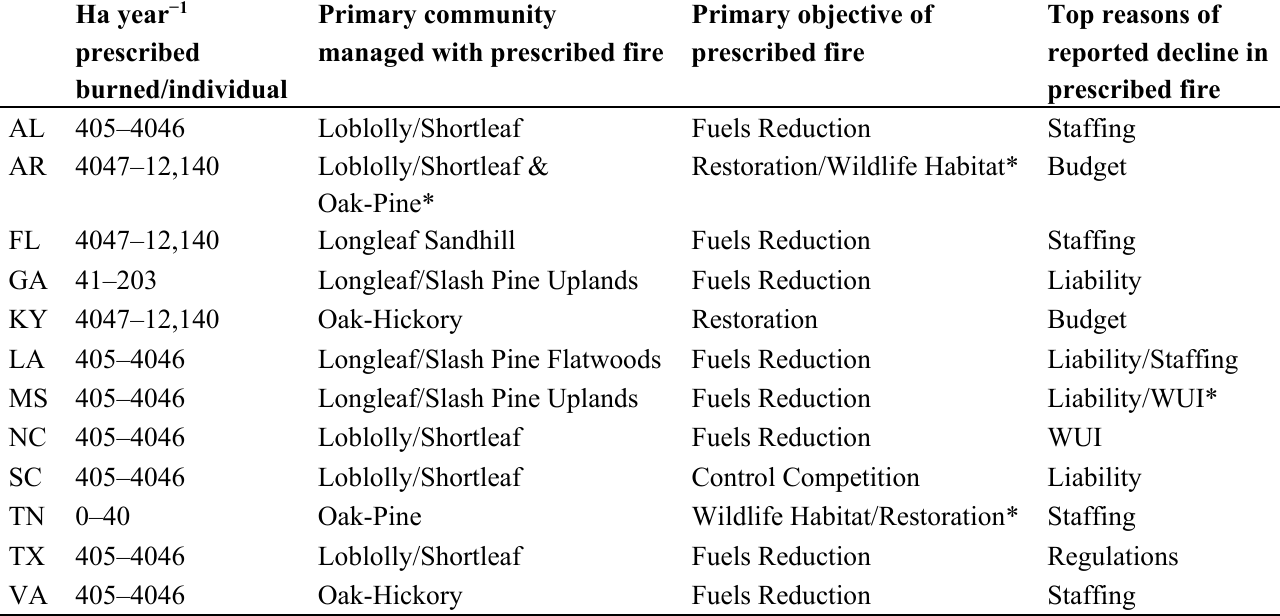
Table 2. Summary of most frequently chosen response by state for prescribed burning objectives, impediments, hectares burned, and primary vegetation community